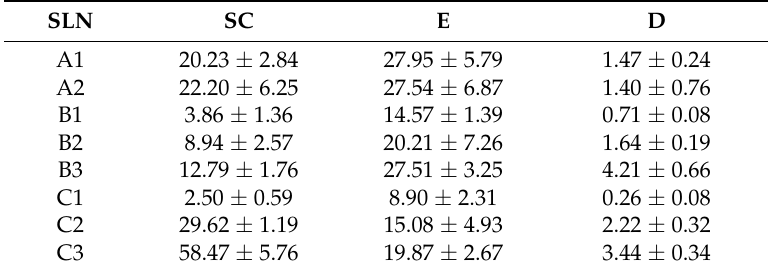
Table 2. Cumulative amount of IDE ( µ g) penetrating different skin layers (SC = stratum corneum; E = epidermis; D = dermis) after 24 h from IDE-loaded SLN. Each value represents the mean of three different experiments ± S.D.